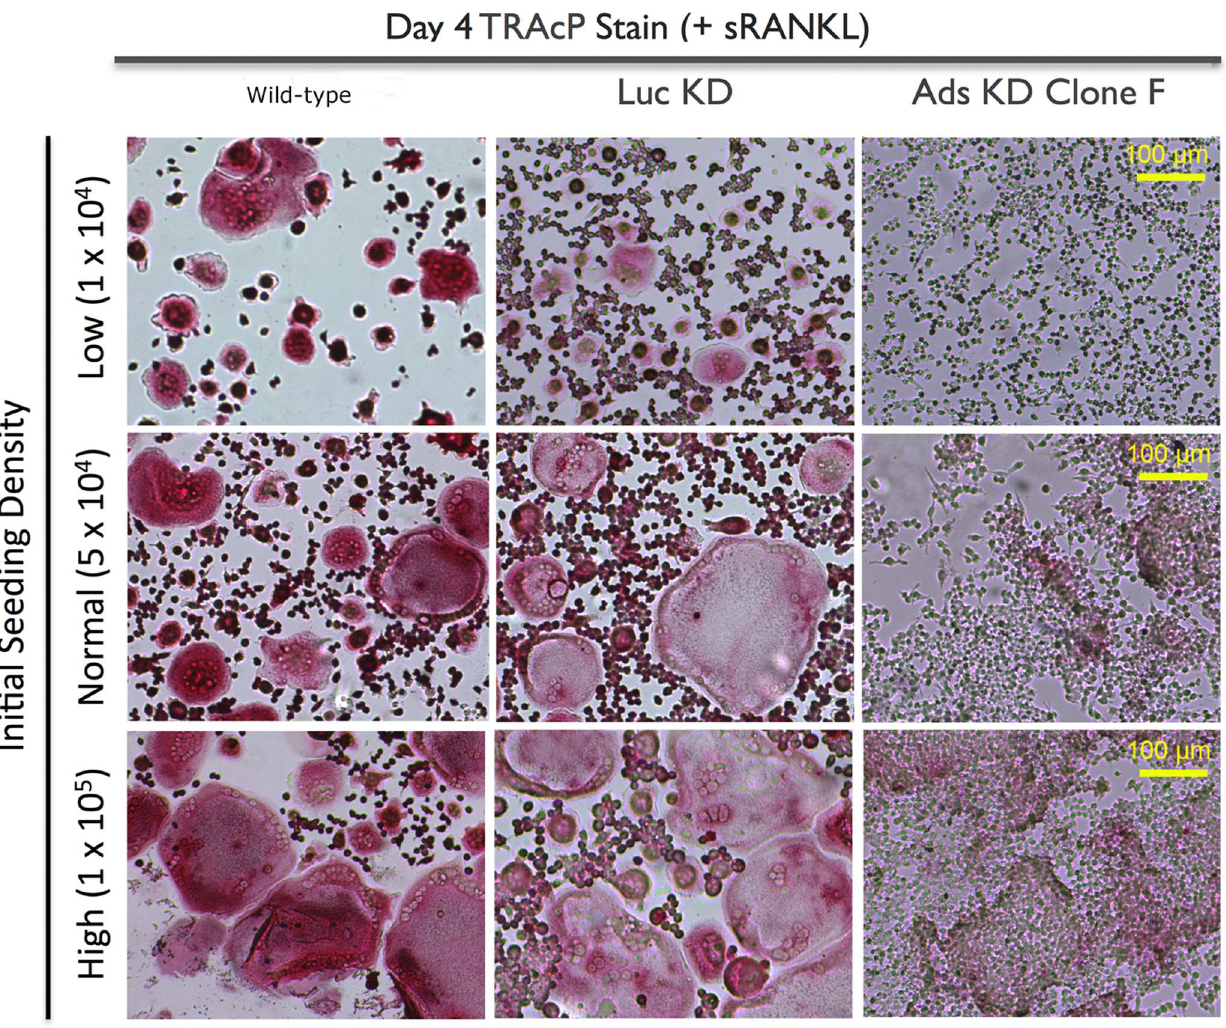
Figure 6. Increased seeding density failed to rescue OCG defect in Adseverin knockdown monocytes. WT, Luc KD and Ads KD (Clone F) monocytes were seeded at three initial plating densities in 12-well tissue culture plates, low (1 6 10 4 cells/well), normal (5 6 10 4 cells/well) and high (1 6 10 5 cells/well). Cells were stimulated for 4 days with sRANKL to stimulate OCG. Representative TRAcP stained photomicrographs are shown. Even at the 10-fold-higher initial plating density, Ads-KD cells failed to form multinucleated osteoclasts, suggestive of a fusion defect.